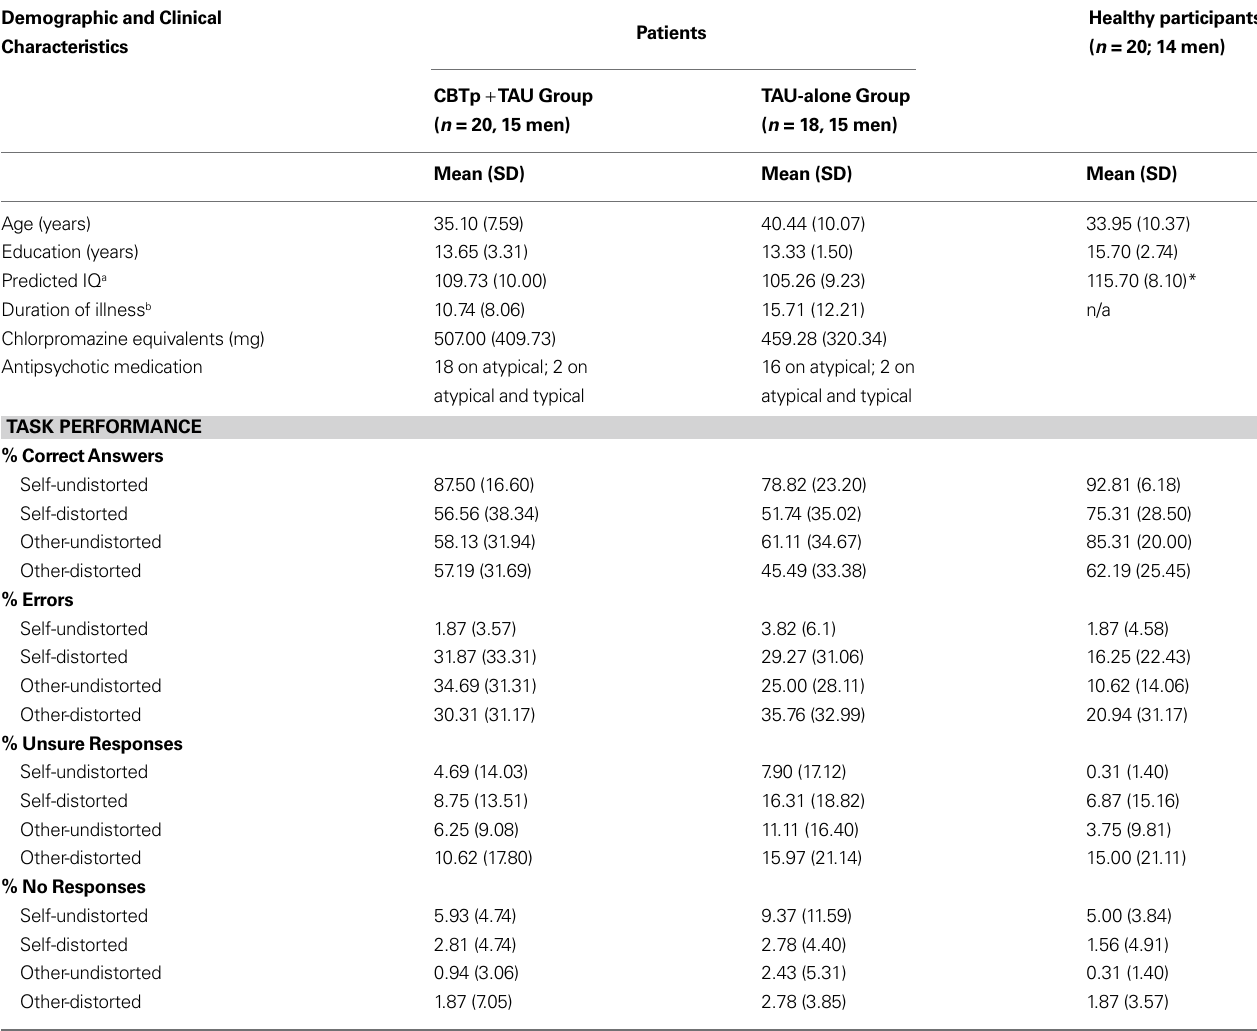
Table 1 | Demographics, clinical characteristics, and task performance of participants. Demographic and Clinical